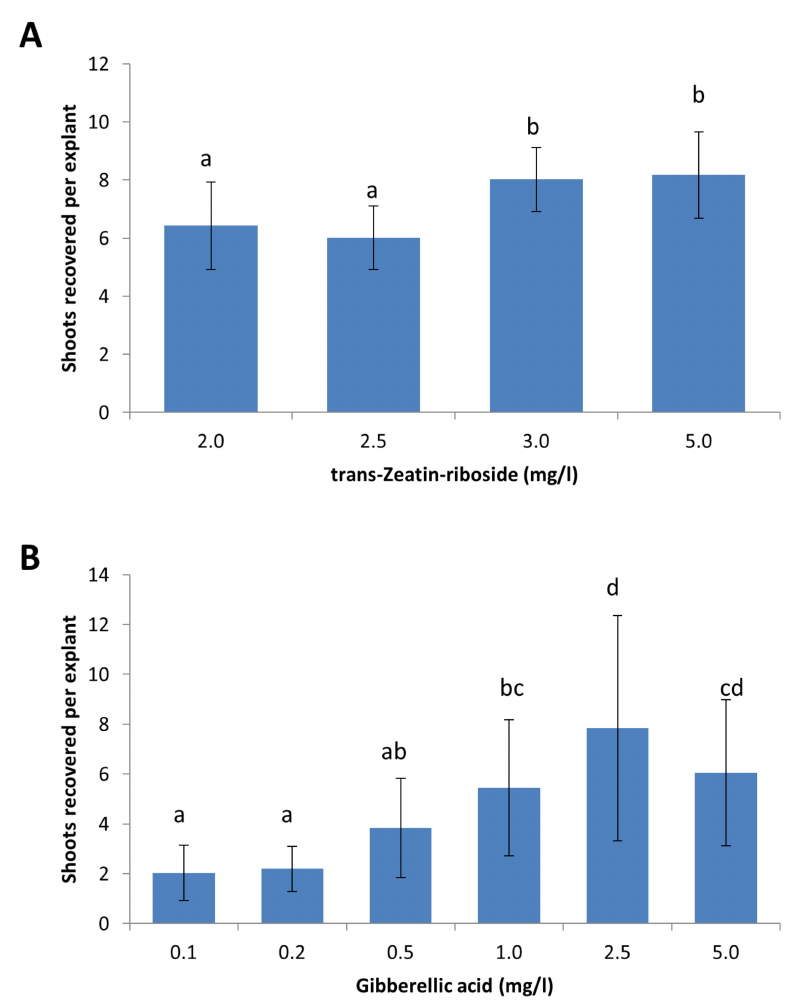
Figure 3. Optimization of plant-growth regulator concentrations for the shoot induction media used for selective regeneration. ( A ) Trans-Zeatin-riboside concentrations were optimized for the induction of shoots from leaf explants of S. tuberosum cv. King Edward. ( B ) Gibberellic acid concentrations were optimized to promote shoot development from dormant buds in B101. Results are expressed as mean ± standard deviation. A total of sixty explants were observed for each treatment and the experiments were repeated twice. Treatments denoted by di ff erent lowercase letters a–d indicate a